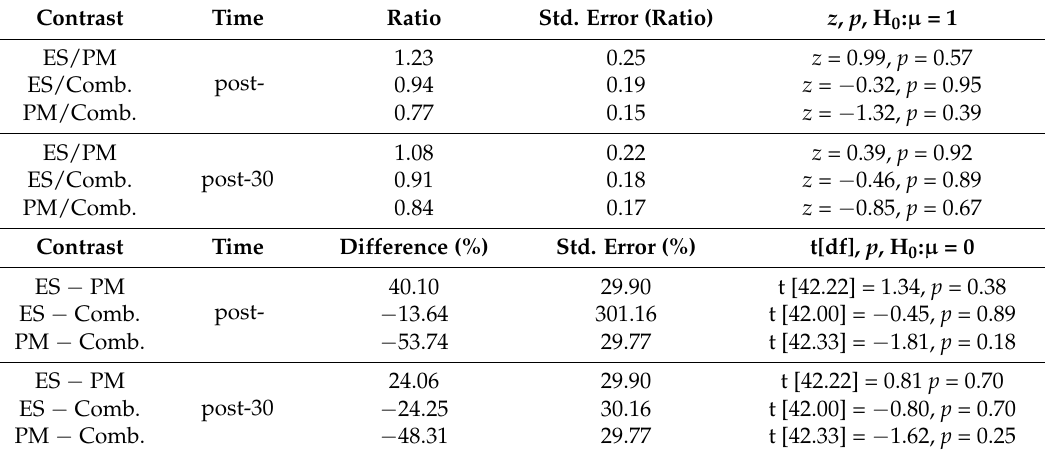
Table 4. Contrasts across sessions and their standard errors estimated from the statistical models.